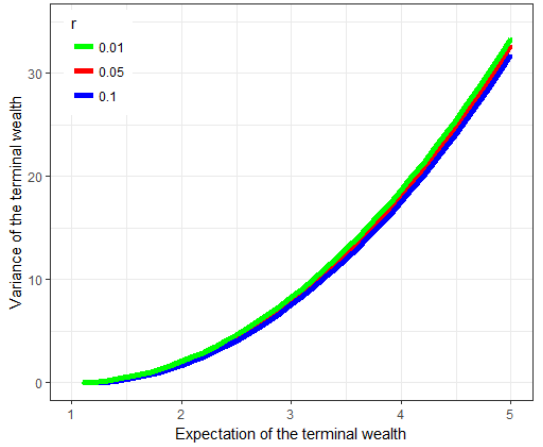
Figure 1. Effects of r on the efficient frontier.